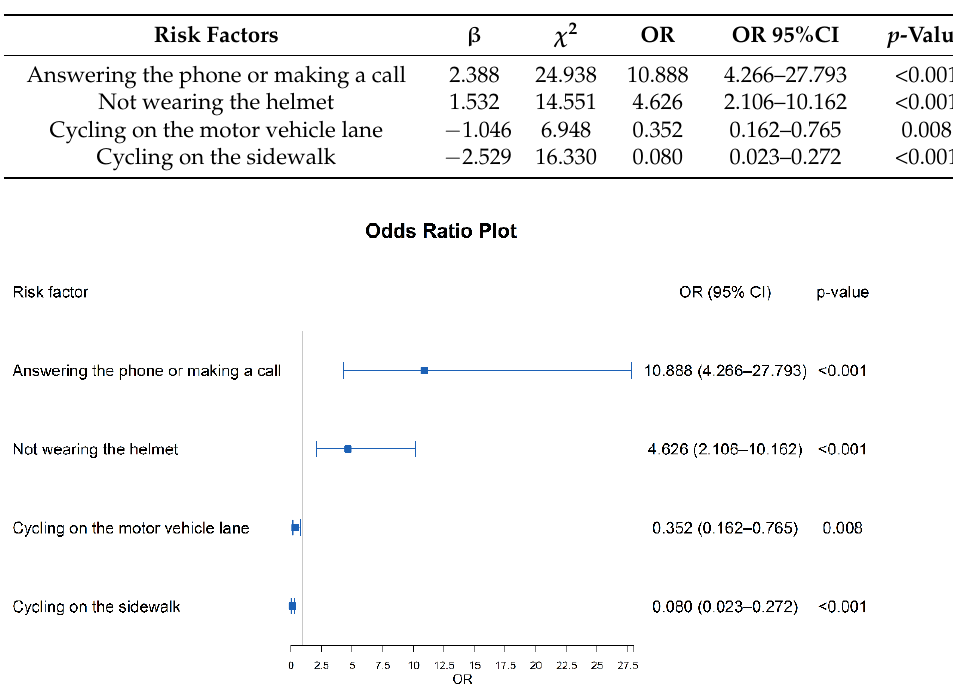
Table 7. Multivariable logistic regression analysis on case-crossover study of ERTIs.